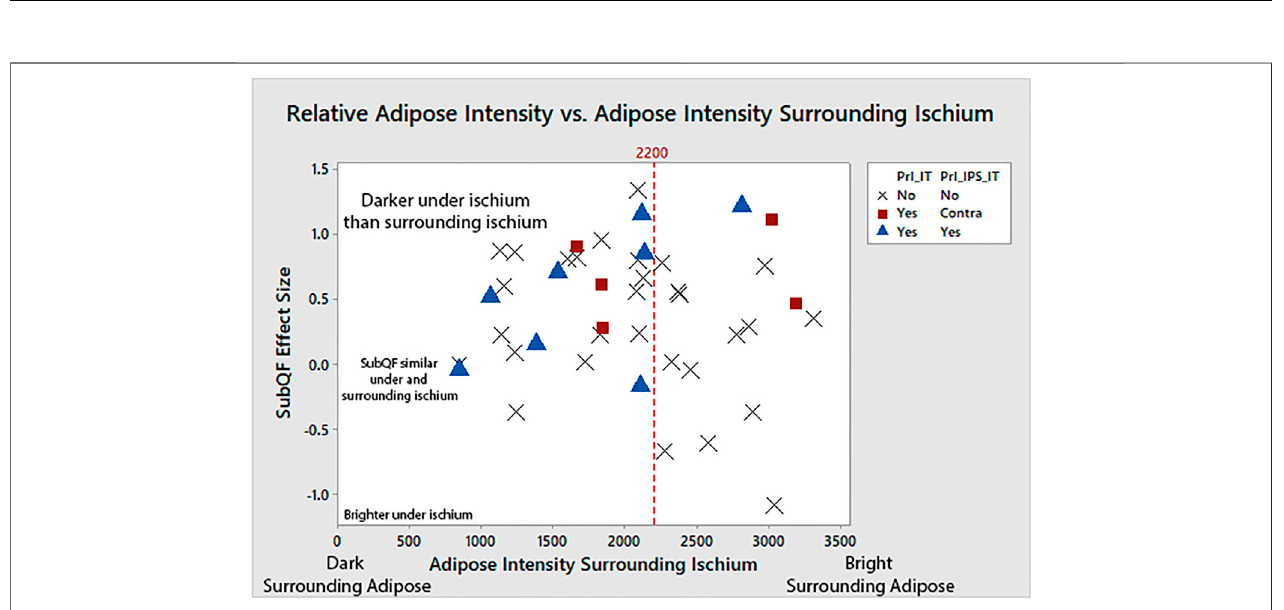
FIGURE 5 | Adipose under the ischium was darker than surrounding adipose (larger SubQF effect size) for people with a history of PrIs, indicating changes to adipose characteristics under the ischium. People with ischial PrIs were also less likely to have bright surrounding adipose.